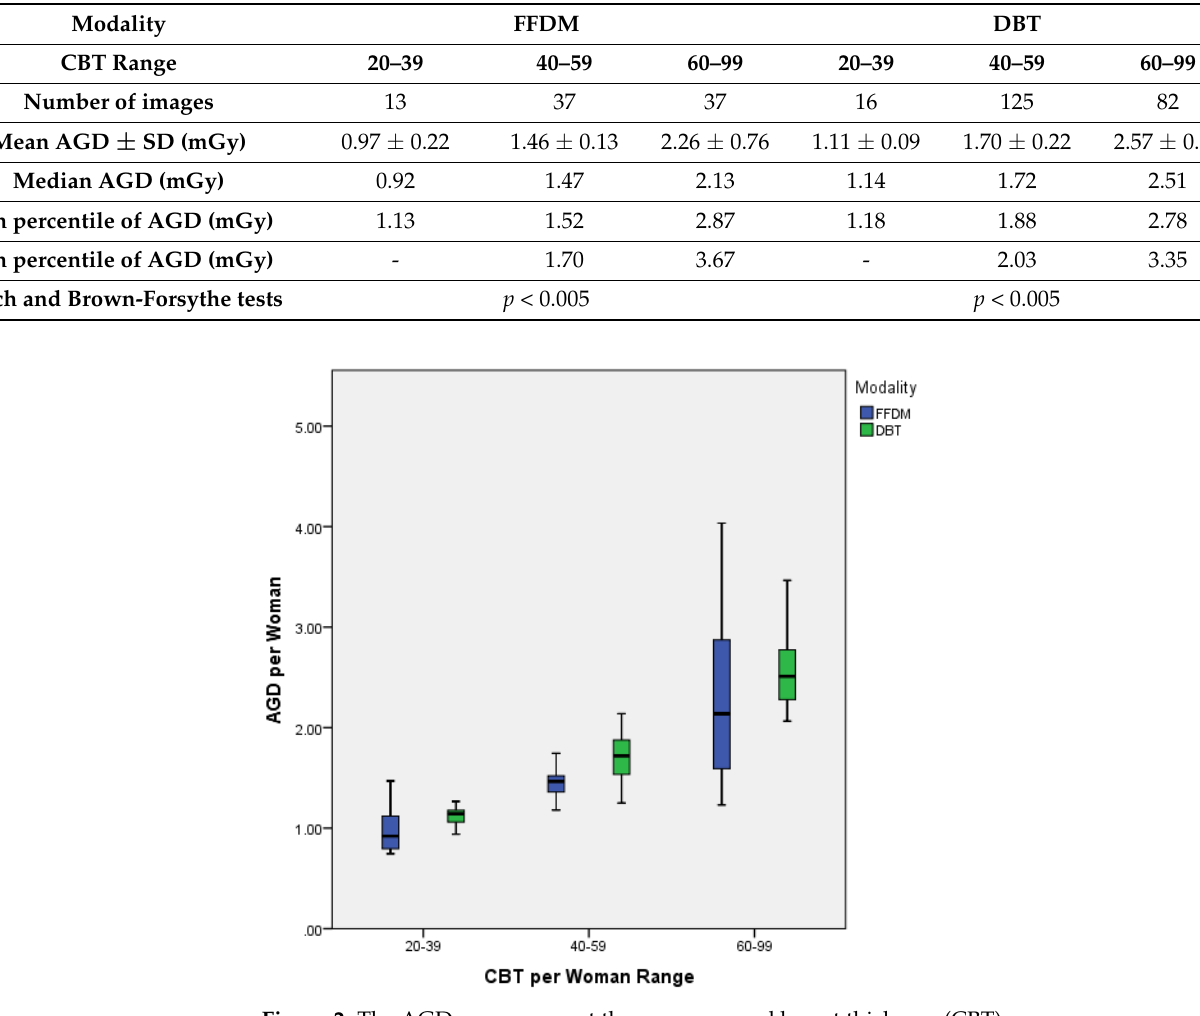
Figure 2. The AGD per woman at three compressed breast thickness (CBT) groups. Table 7. Comparison of the compressed breast thickness (CBT) and AGD values of full-field digital mammography (FFDM) at 75th and 95th percentile with corresponding previously published val- ues.